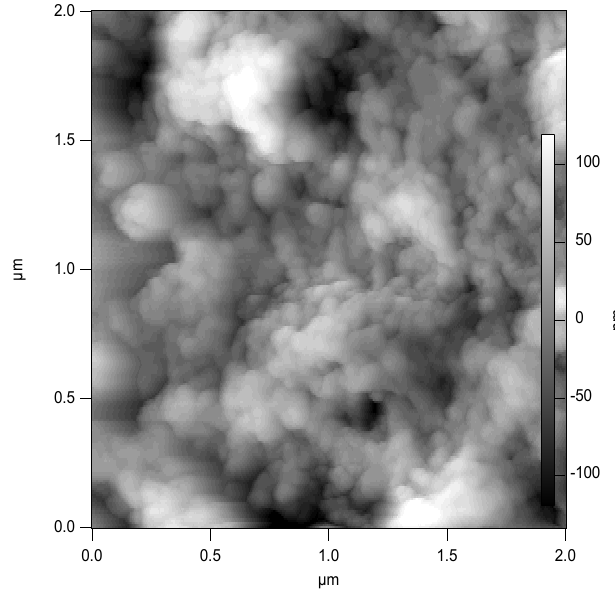
Figure 11. AFM image recorded for a SWCNT assembly dispersed randomly on a silicon surface on which glucose oxidase was adsorbed for a 2.5 hr period at room